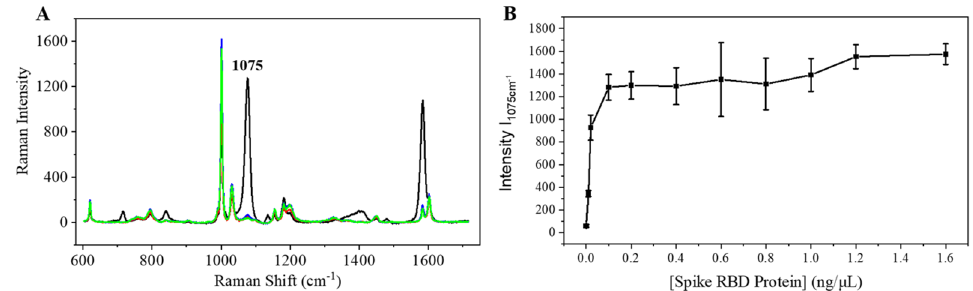
Figure 5. Functional validation of our SERS-based diagnostic test. ( A ) Averaged SERS spectra collected from AgNPs@MBA@SiO 2 @Ab in the presence of 100 ng/mL antigenic spike RBD protein (black) and in the absence of antigen (red), capturing antibody (blue) or both (green). In the absence of capturing antibody, the concentration of antigen was increased to 1 μg/mL. ( B ) SERS intensity at 1075 cm −1 provided by the